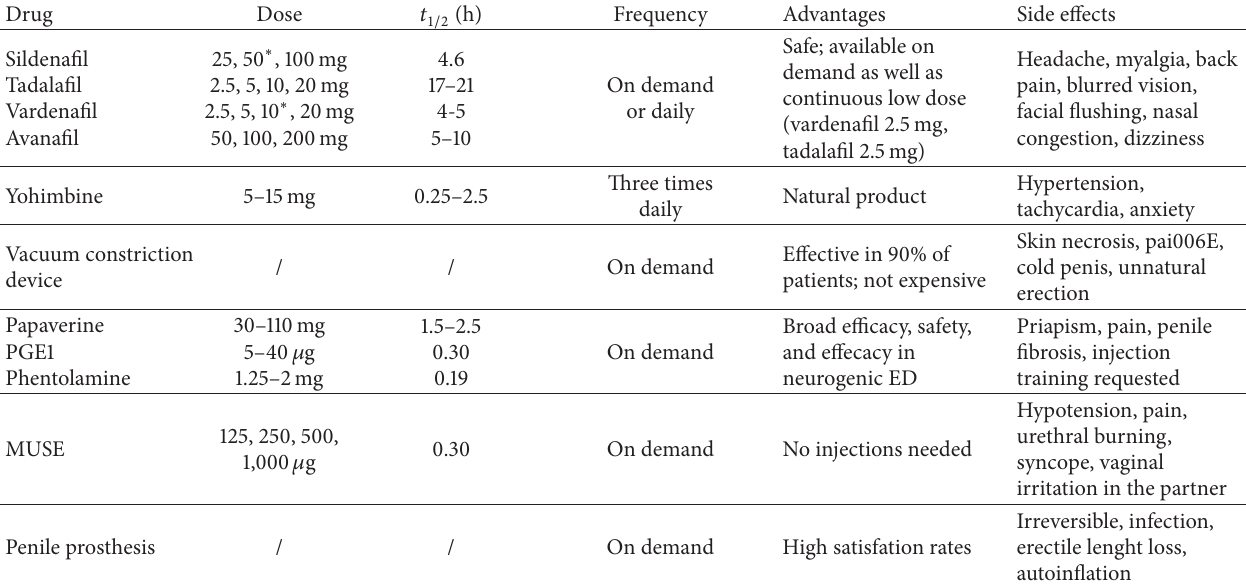
Table 2: Summarizing the possible treatment options for ED in elderly